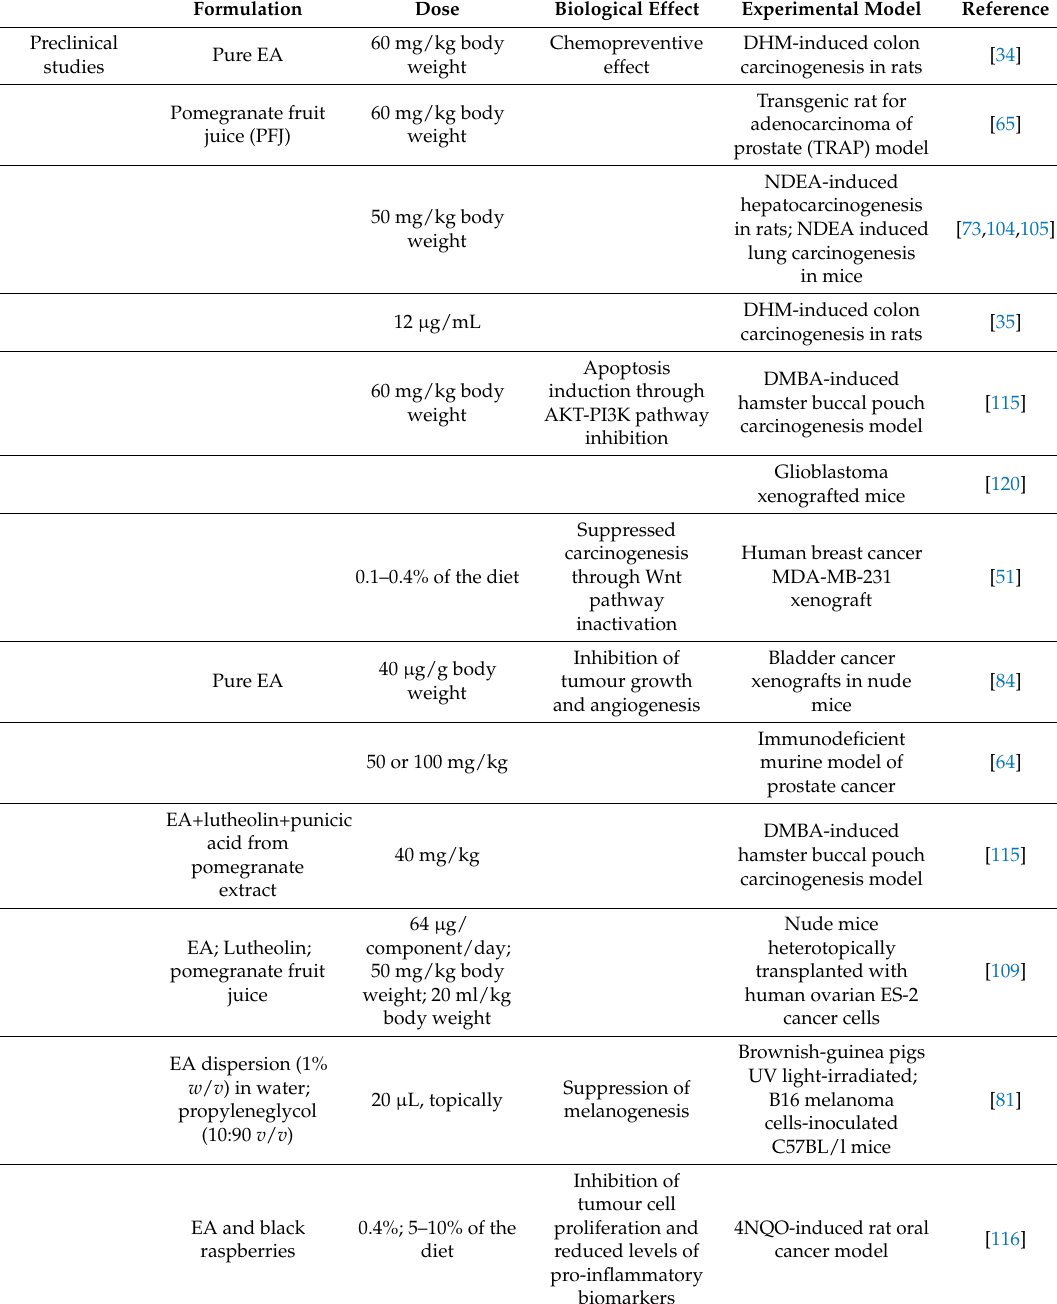
Table 3. In vivo preclinical and clinical evidence of ellagic acid (EA) therapeutic